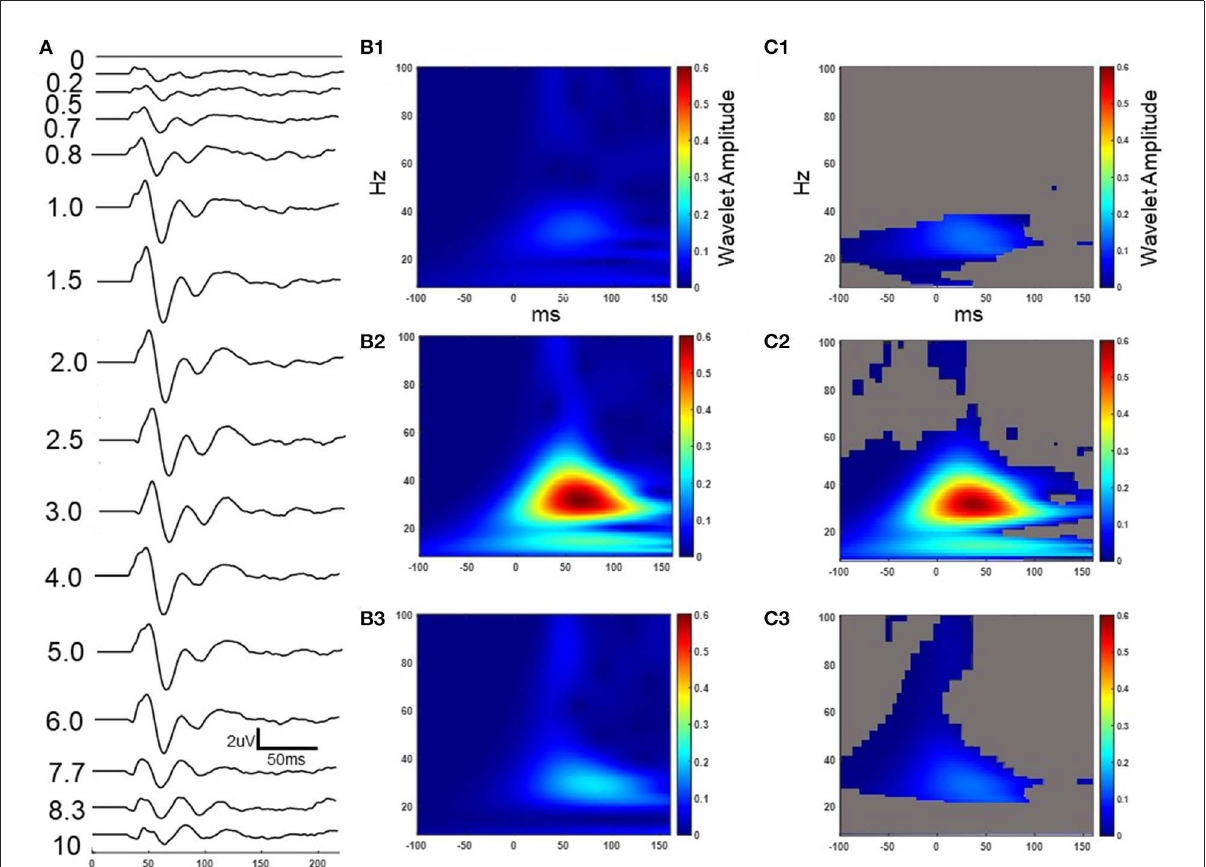
FIGURE5 Example STN evoked response to increasing IPIs from participant 3 while on medication. The result in the time domain post subtraction of the single pulse from the paired pulse at increasing IPIs (A) . The wavelet response of the time domain subtracted 0.2, 2.5, and 10 ms IPI conditions from column A ( B1–B3 respectively). Permutation statistics comparing wavelet amplitude differences in the frequency domain between the single pulse and non-subtracted paired pulses at the 0.2, 2.5, and 10 ms IPIs with non-significant time-frequency zones shown in gray ( C1–C3 respectively). Z scales are wavelet amplitudes and time zero is aligned to the stimulation artifact with plots showing frequencies between 8-100